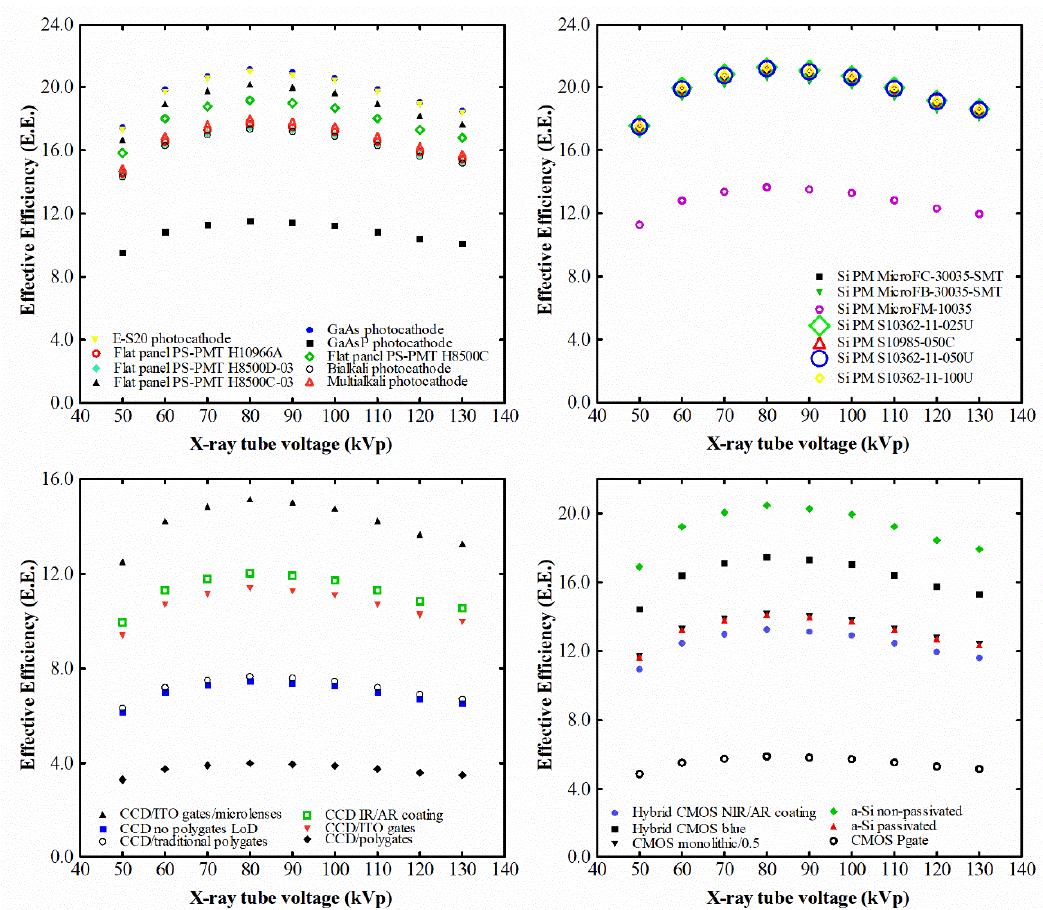
Crystals 2019 , 9 , x FOR PEER REVIEW Figure 3. E ff ective e ffi ciency of the CaF 2 :Eu single crystal. Figure 3. Effective efficiency of the CaF 2 :Eu single crystal.